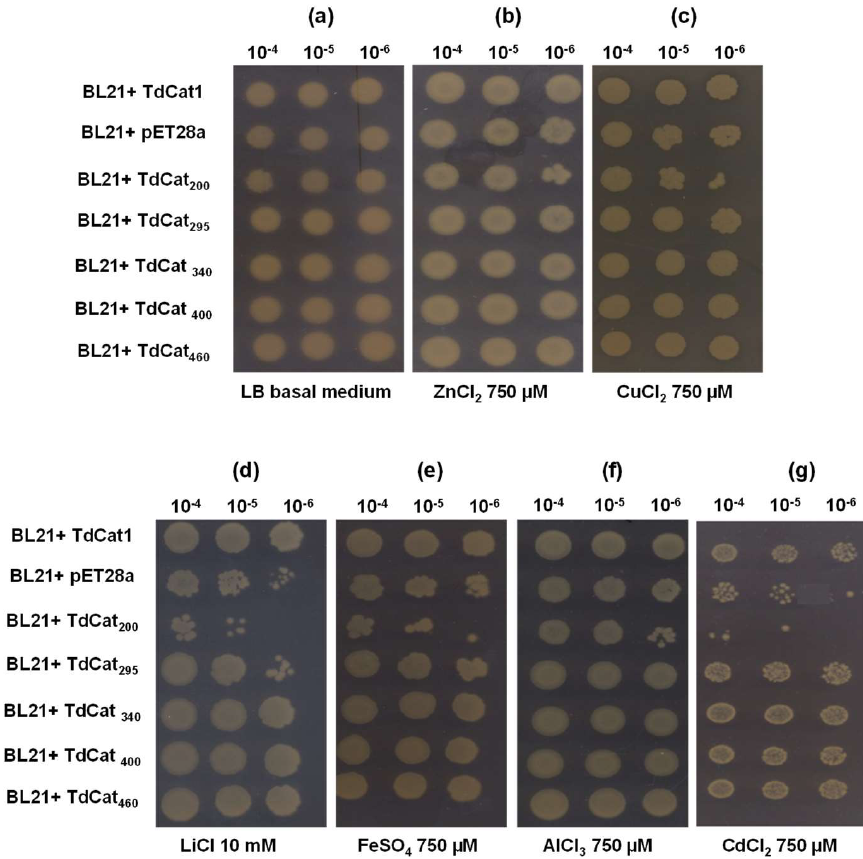
Figure 7. Functional characterization of TdCAT1 gene expressed in E. coli (BL21 strain) in response to heavy metals stress. Bacterial cells transformed with the empty vector (pET28a) and with the recombinant vectors (pET28a + TdCAT1 or derivative forms) were grown for 24 h under normal growth conditions (LB medium, ( a )) or after the addition of 750 µ L of ZnCl 2 ( b ), 750 µ M CuCl 2 ( c ), 10 mM LiCl ( d ), 750 µ M FeSO 4 ( e ), 750 µ M AlCl 3 ( f ), or 750 µ M CdCl 2 ( g